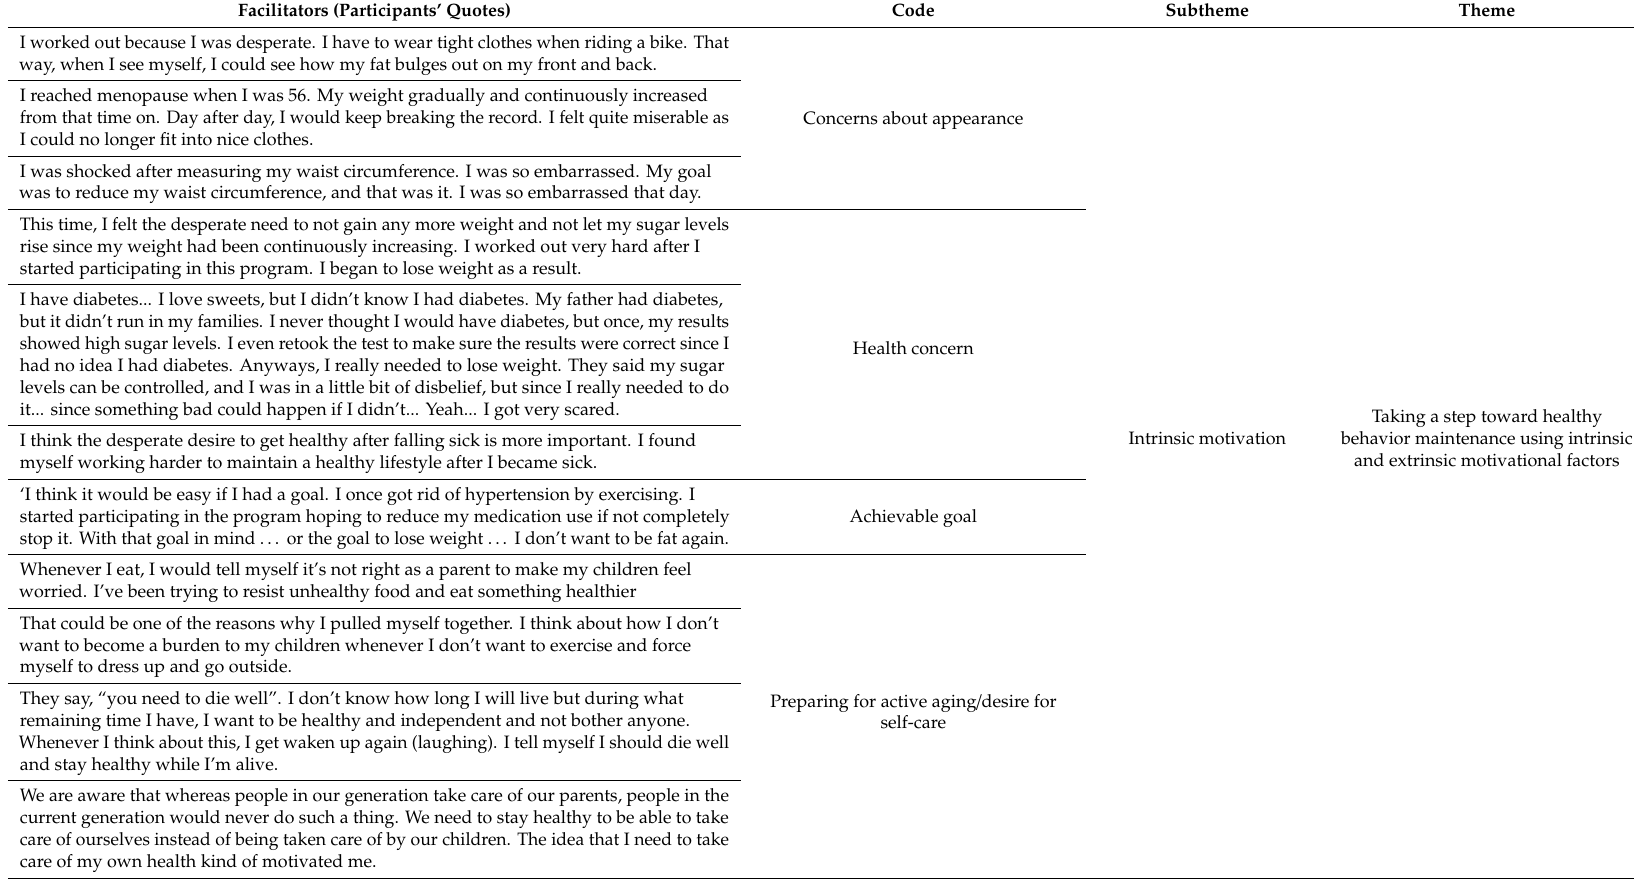
Table 2. Facilitators of healthy lifestyle modification and